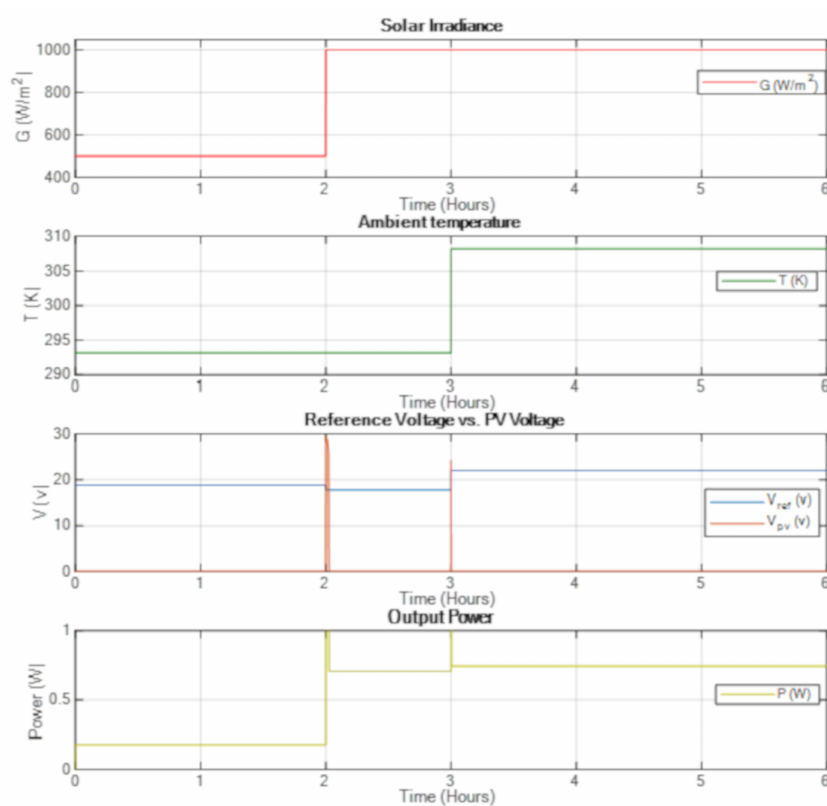
Figure 16. Output Power without Regulator for R = 100 Ω